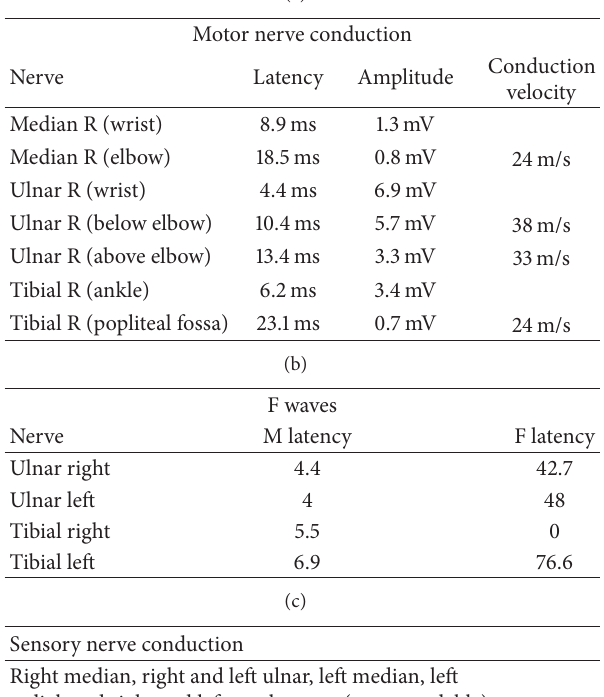
Table 1: Nerve conduction studies performed during an exacerba- tion of CANOMAD.